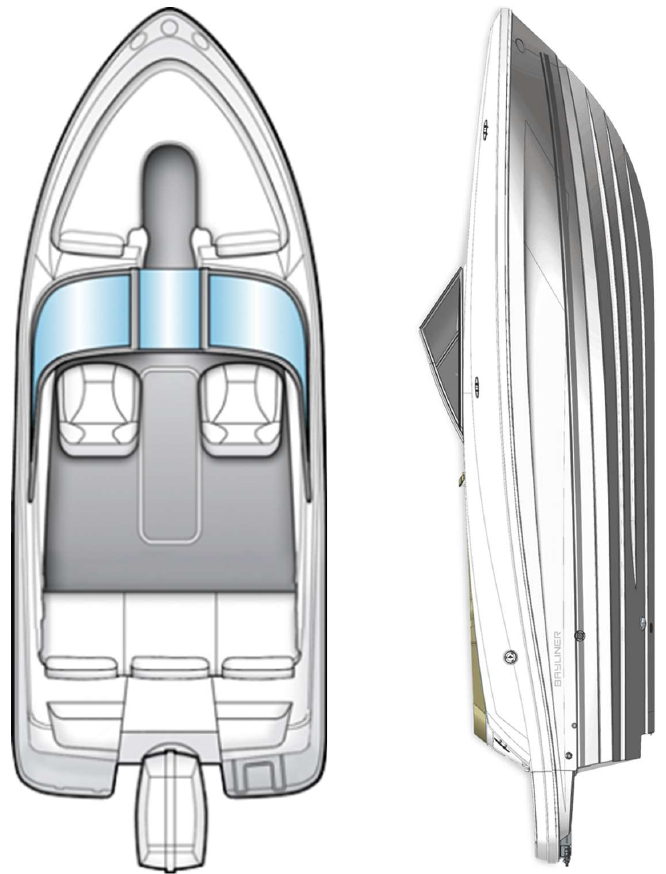
Figure A1. Top and side view of planing hull.